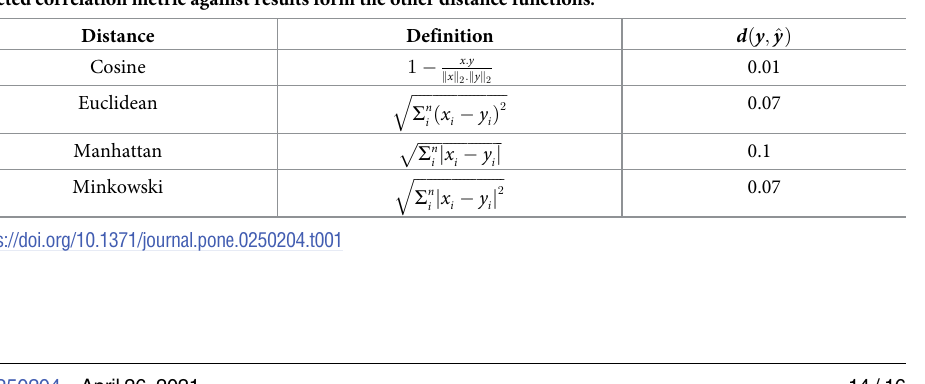
Table 1. Clustering stability measured by the hamming distance d ð y ; ^ y Þ of the clustering results of using the selected correlation metric against results form the other distance